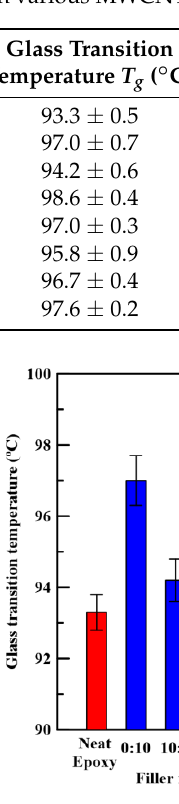
Figure 7. Variation of measured glass transition temperatures of the studied nanocomposites T g with the employed filler ratios in the specimen preparation.